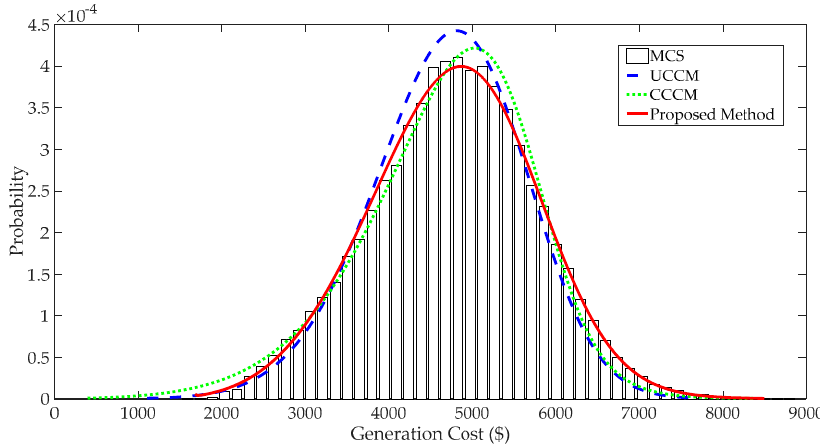
Figure 5. PDFs of generation cost (modified IEEE 9-bus test system). Energies 2017 , 10 , 1623